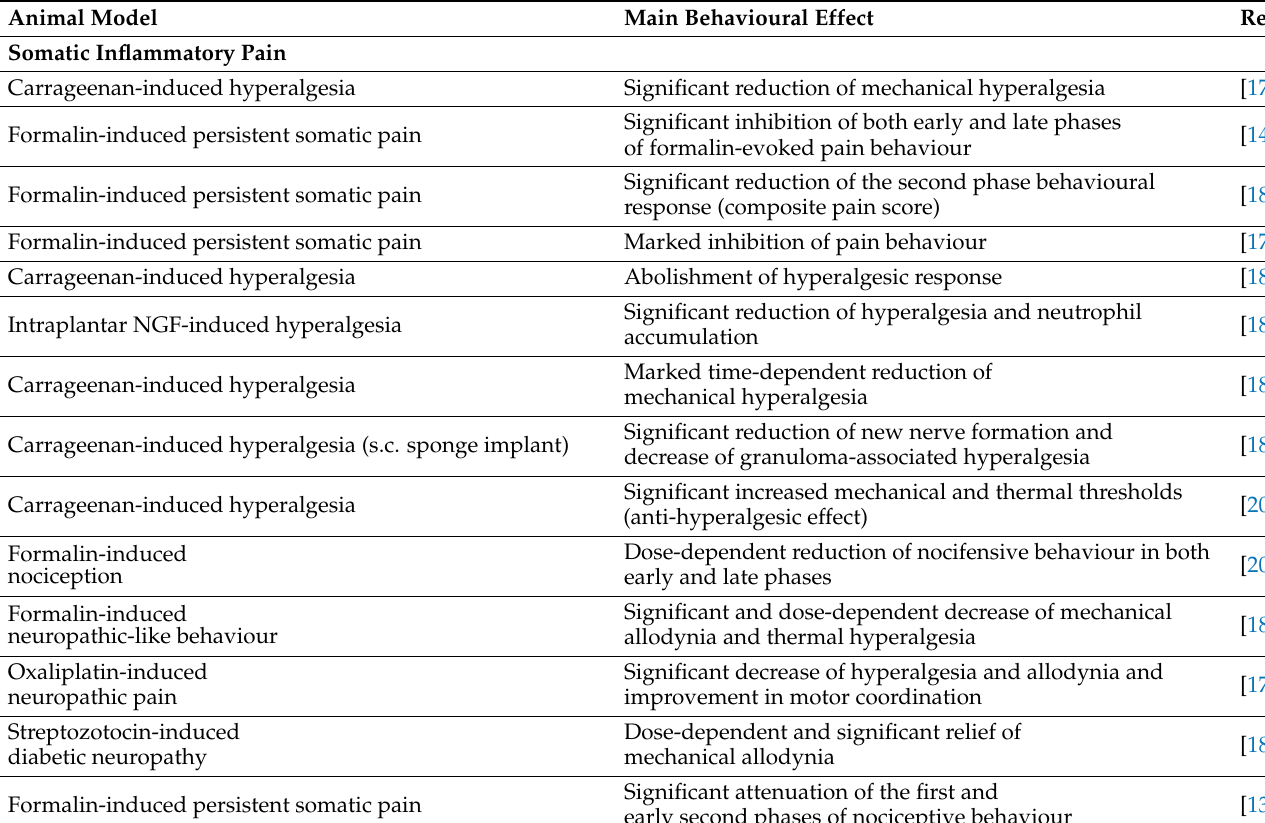
Table 3. Pain relieving effect of PEA—mainly given via intraperitoneal route—in animal models of chronic inflammatory pain. Summary of studies in chronological